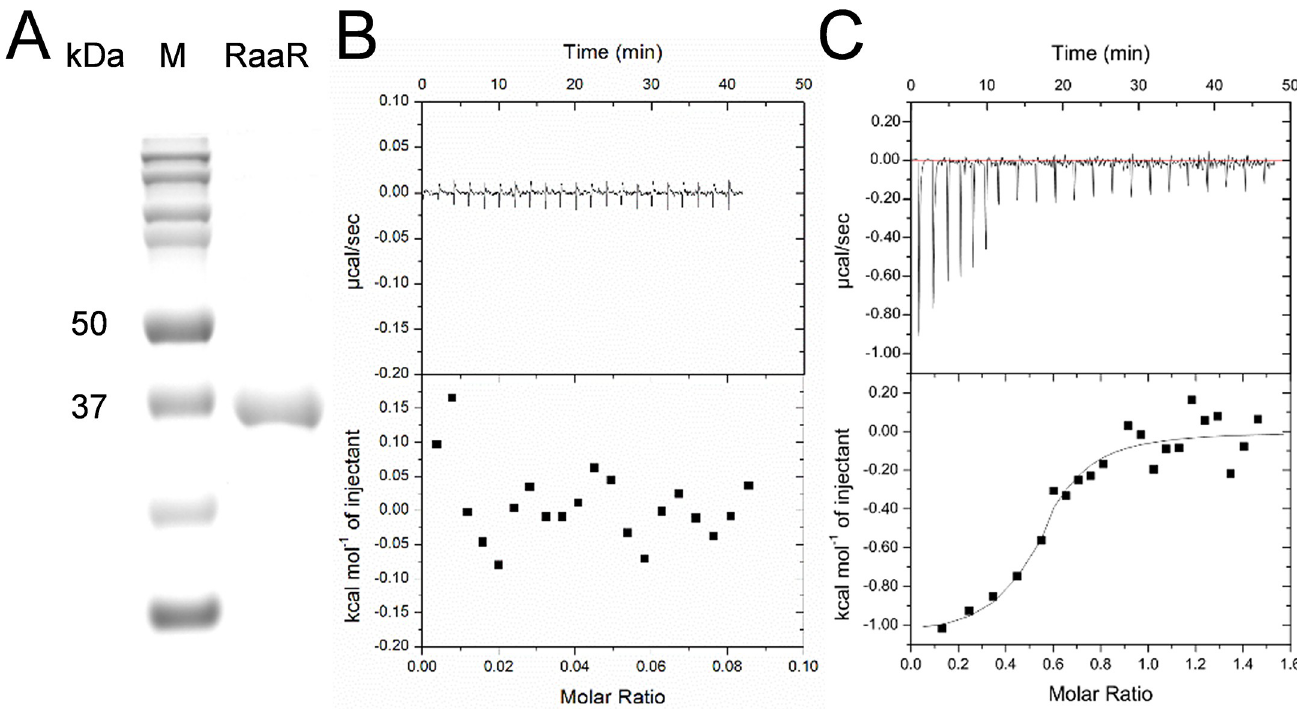
Fig 4. ITC analysis of the binding of anthranilic acid to RaaR protein. (A) SDS-PAGE of the purified RaaR protein. (B) ITC titration of 250 μ M anthranilic acid in PBS buffer at 25˚C. (C) ITC titration of 20 μ M RaaR with 250 μΜ anthranilic acid in PBS buffer at 25˚C.